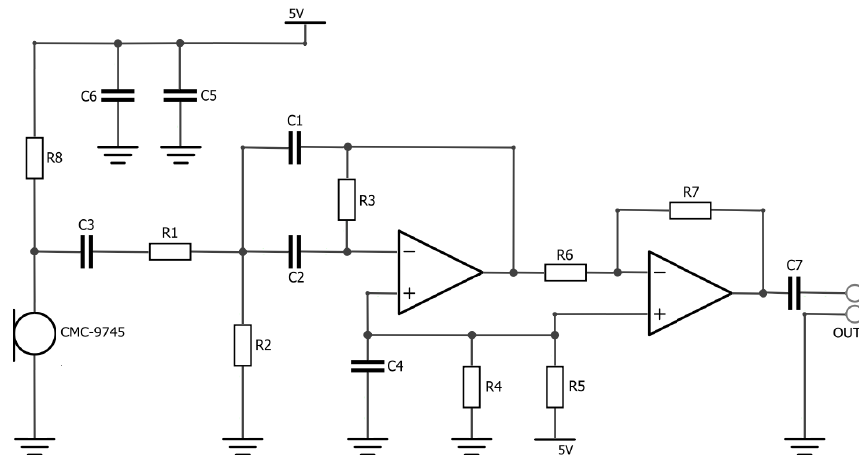
Figure 6. Circuit configuration for acoustic measurement: multi-feedback bandpass filter and amplification.